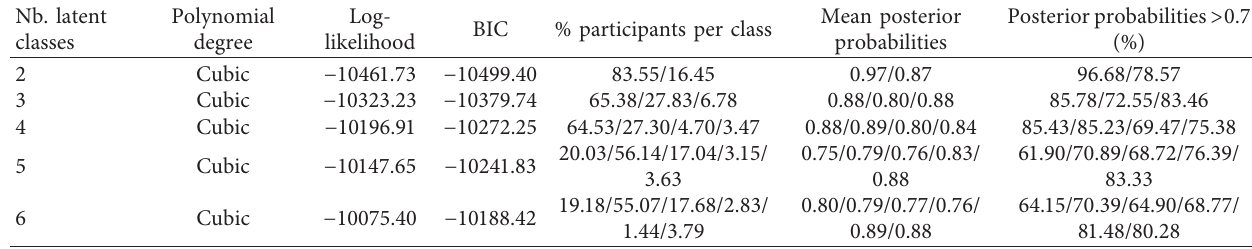
Table 1: Parameter estimates for the latent class growth mixture modeling.